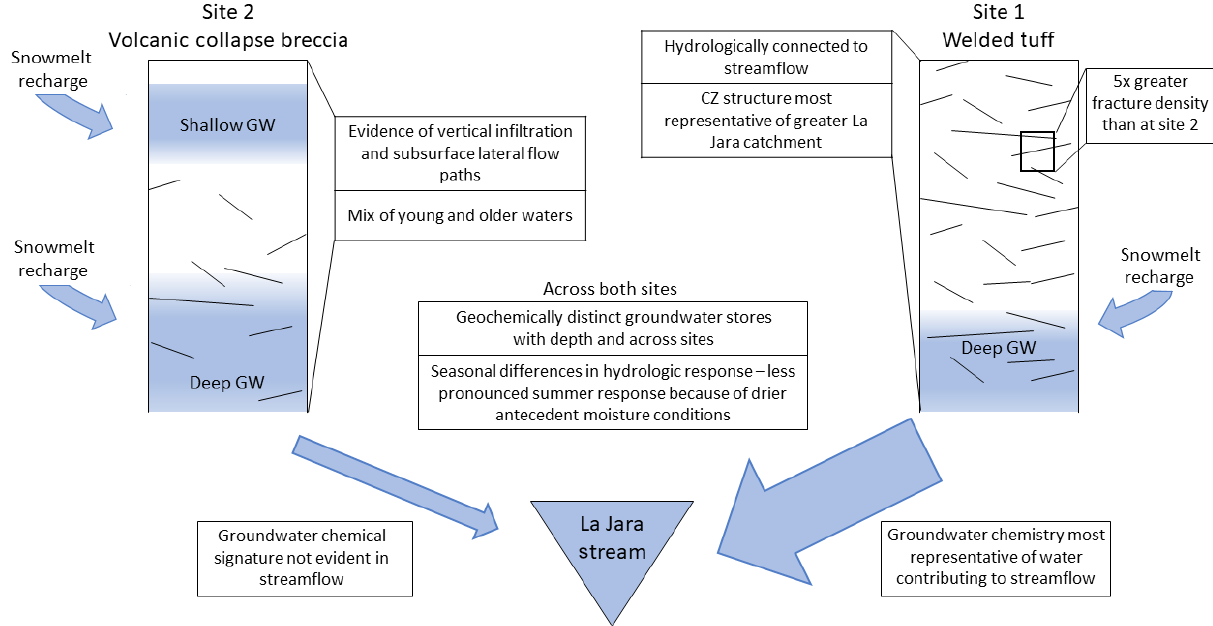
Figure 10. Schematic of intricacies of the hydrologic structure and function across two contrasting sites within the ZOB (sites 1 and 2). Site 2 has multiple, separate stores of groundwater across depth that are distinct from each other and distinct from deep groundwater stores at site 1. All groundwater is recharged via snowmelt and seasonal differences in hydrologic response to precipitation inputs exist at both sites with a less-pronounced response to summer monsoons. There is evidence of vertical infiltration and subsurface lateral flow at site 2 and a mix of young and older waters, which are expected to persist across all groundwater stores. The fracture density at site 1 is approximately 5 times greater than at site 2, and the CZ structure and architecture of site 1 is most representative of the greater catchment. Deep groundwater from the fractured aquifer system at site 1 is hydrologically connected to streamflow, and site 1 deep groundwater chemistry is most representative of water contributing to streamflow, while the distinct chemical signature of shallow groundwater from site 2 is not evident in